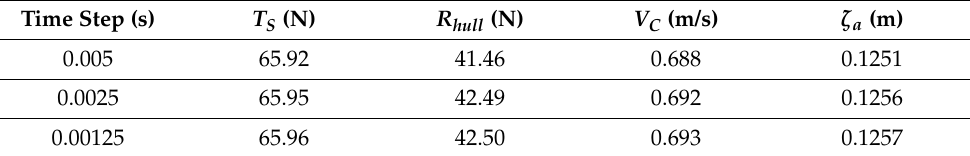
Table 4. Physical quantities under different time steps.